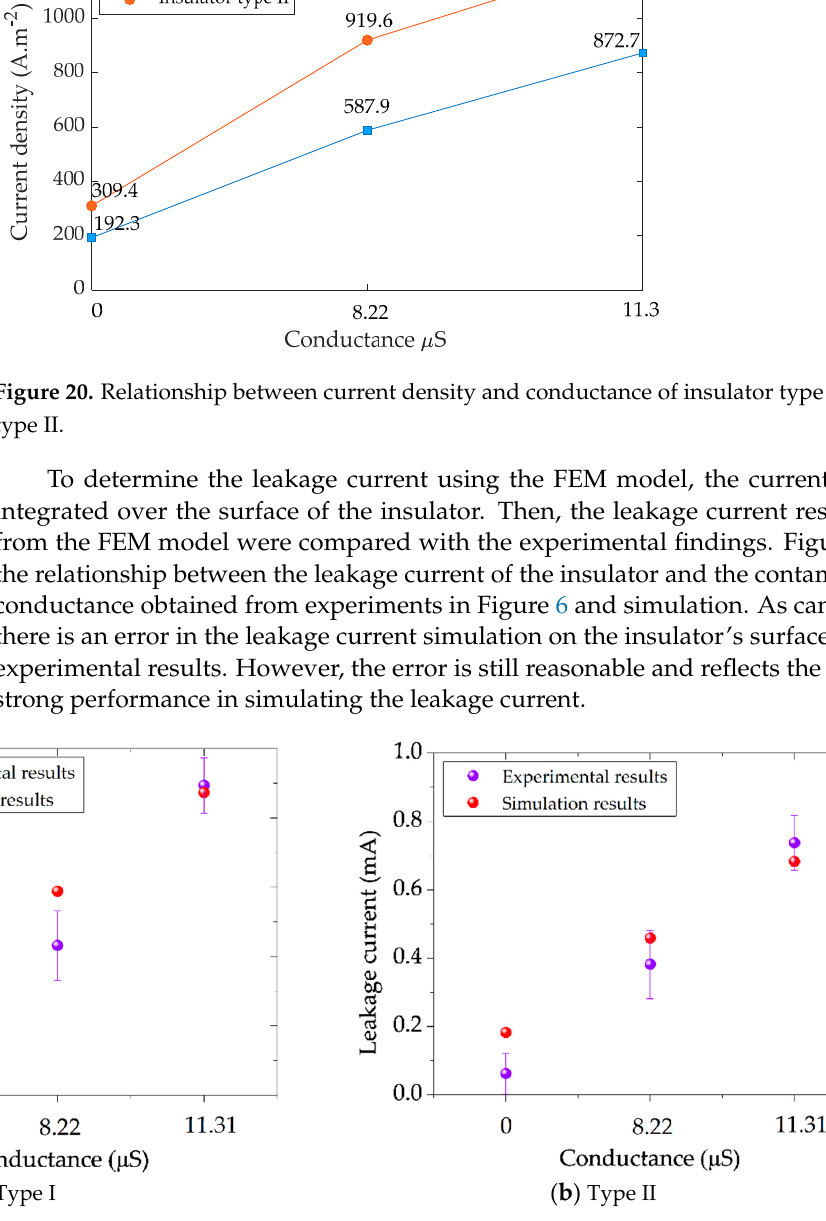
Figure 21. ( a ) Comparison between simulation and experimental results of the leakage current under three different conductance conditions for insulator type I; ( b ) Comparison between simulation and experimental results of the leakage current under three different conductance conditions insulator type